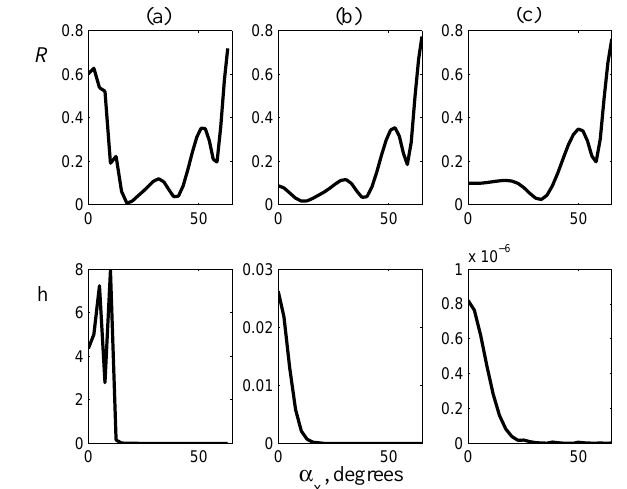
Figure 3. The energy reflection coefficient R and the normalized amplitude of the horizontal magnetic field of the wave on the ground surface h as functions of α x : (a) α y = 0, (b) α y = 17 ◦ , and (c) α y = 34 ◦